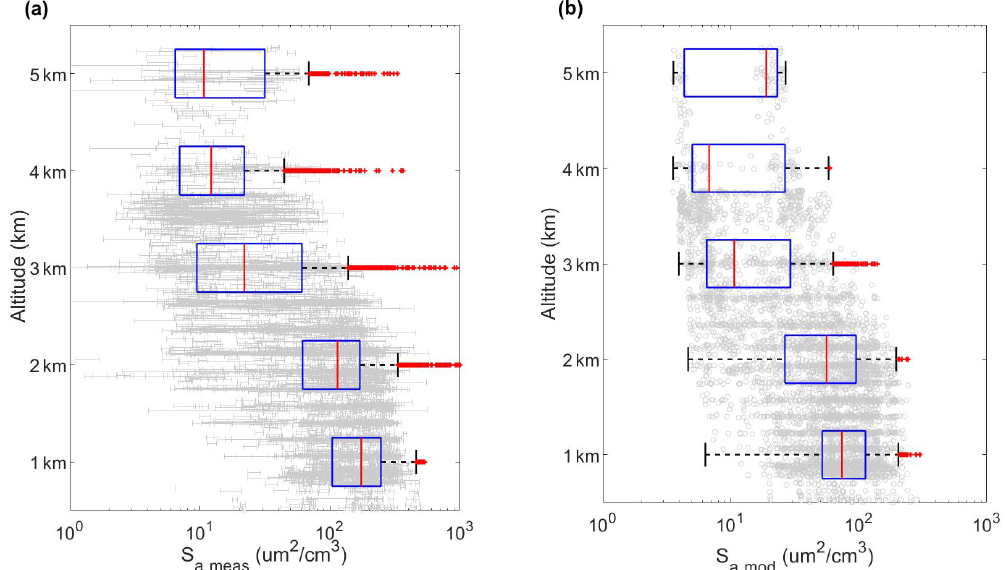
Figure 4. Average vertical profile of (a) measured DISCOVER-AQ aerosol surface area concentration ( S a , meas ) and (b) CMAQ aerosol surface area concentration ( S a , mod ) over the entirety of the DISCOVER-AQ campaign. Each measured point is an average of the points included in that 4D index corresponding to CMAQ. The overlaid box plots show the median (red line within blue box) and interquartile ranges (blue box with the 25th percentile at the left end and 75th percentile at the right end) in 1km altitude bins. The labels on the altitude axis lie at the midpoint of the 1km altitude bin, and red crosses indicate outliers from the majority of the dataset at that altitude